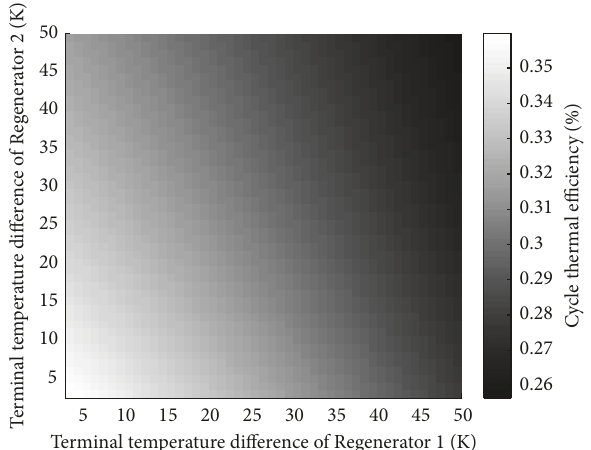
Figure 6: Effect of condenser outlet temperature on the thermal efficiency for different cycle pressure